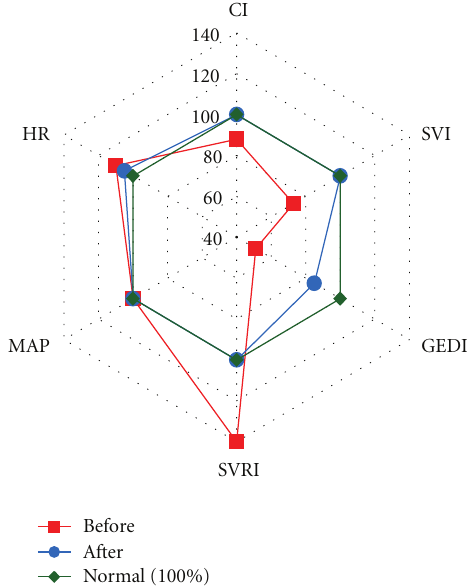
Figure 3: Variant STBI-a of hemodynamic reaction on the first day of monitoring before and after correction. Note. Hemodynamic parameters are presented with percents from the normal value.